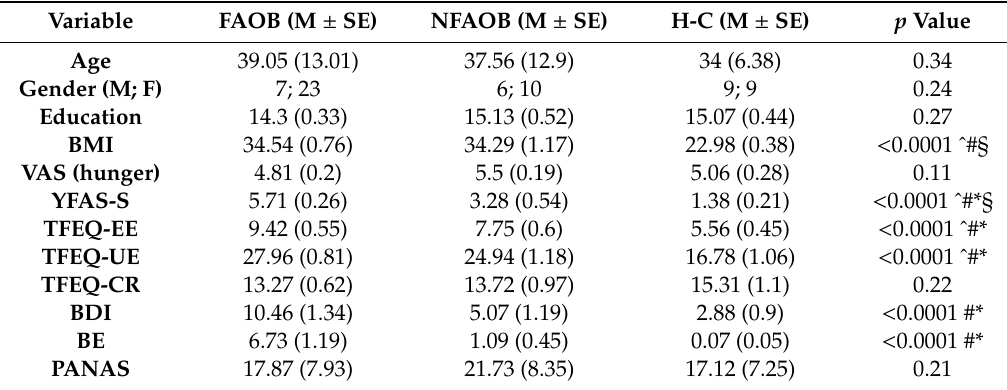
Table 1. Demographic and clinical data of the participants in the